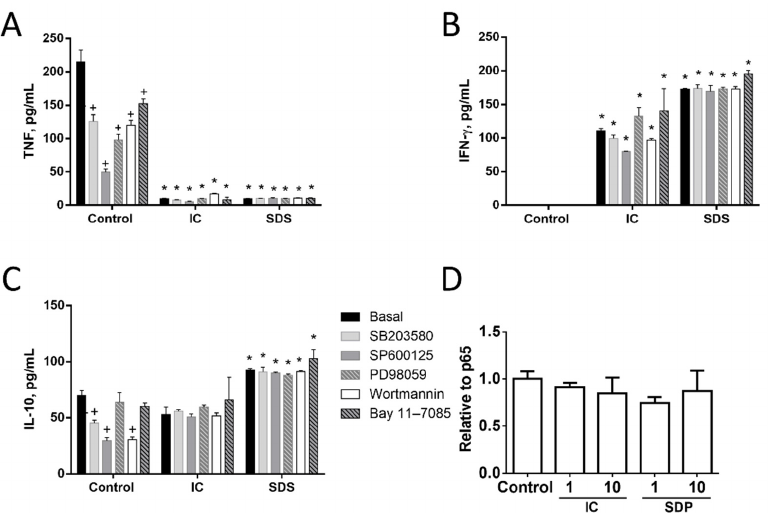
Figure 5. Effects of immunoglobulin concentrate (IC) and spray dried serum (SDS) on the production of TNF ( A ), IFN- γ ( B ), and IL-10 ( C ) by rat splenocytes. IC or SDS (10 mg/mL) were added to the cell culture medium. Vehicle (DMSO) or inhibitors for p38 MAPK (SB203580, 10 µM), JNK (SP600125, 10 µM), ERK1/2 (PD98059, 10 µM), phosphatidylinositol 3-kinase (wortmannin, 1 µM) or NF- κ B (Bay 11–7085, 10 µM) were added to rat splenocytes 2 h before the addition of IC or SDS and cytokines were measured by ELISA in the 24 h supernatant. ( D ) Effect of IC and SDS on NF- κ B p65 translocation to the nucleus. Splenocytes were incubated with IC and SDS for 15 minutes and nuclear content was extracted for p65 detection by ELISA. Data are represented as mean ± SEM and are representative of two independent experiments ( n = 3). * p < 0.05 vs. the corresponding Control group; + p < 0.05 vs. the corresponding Basal (no inhibitor) group.